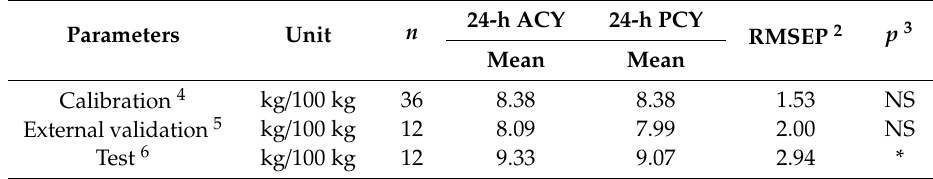
Table 5. Evaluation of the predicting ability of the cheese yield formula 1 developed here: comparison between actual (24-h ACY) and predicted cheese yield (24-h PCY) in calibration, validation and test